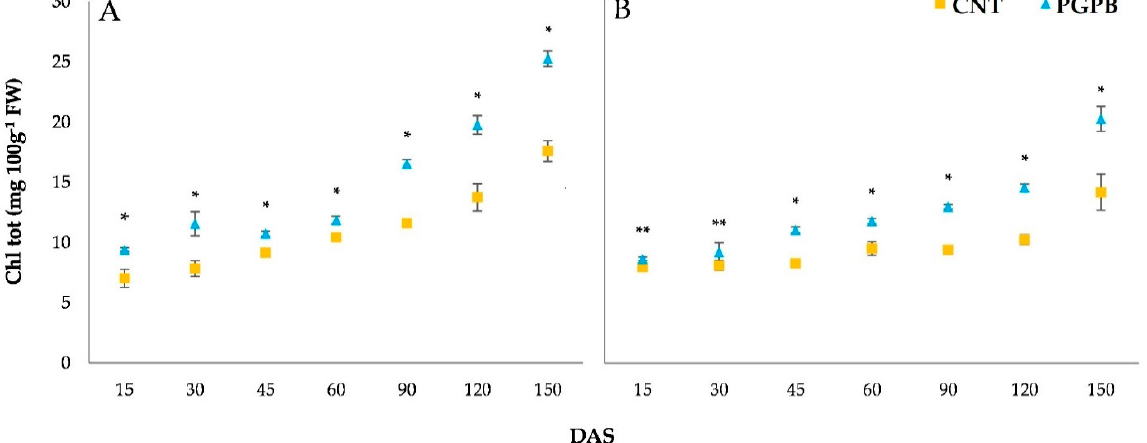
Figure 3. Dry weight dynamics recorded for Meranto ( A ) and Moondance ( B ). In the figure: CNT = Control; PGPB = treated seed; DAS = days after sowing; * = p < 0.001.